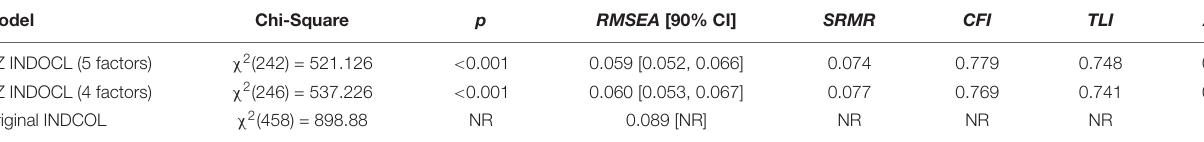
TABLE 4 | The INDCOL fit indices compared to the original version by Singelis et al. (1995). Model